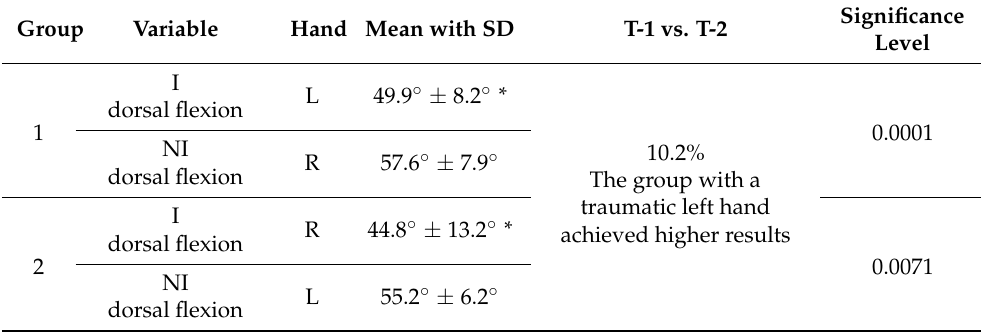
Table 3. Comparison of results for dorsal flexion.